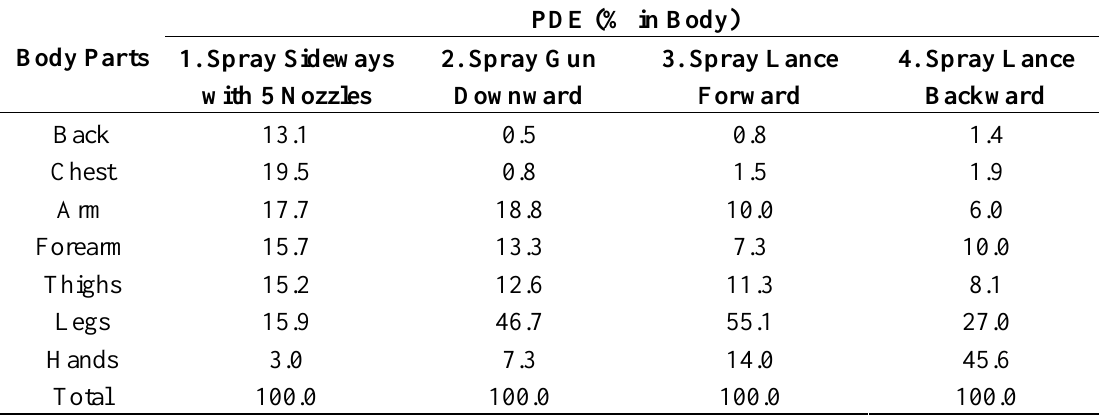
Table 3. Comparison of the distribution of PDE for different application techniques. The values represent the percentages of the PDE distributions on the body parts. Technique 1 corresponds to the present study and techniques 2–4 correspond to experiments made in greenhouse pepper crops in Spain and Greece